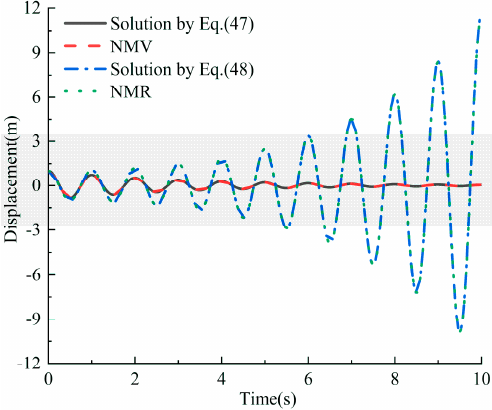
Figure 1. Free vibration solutions.